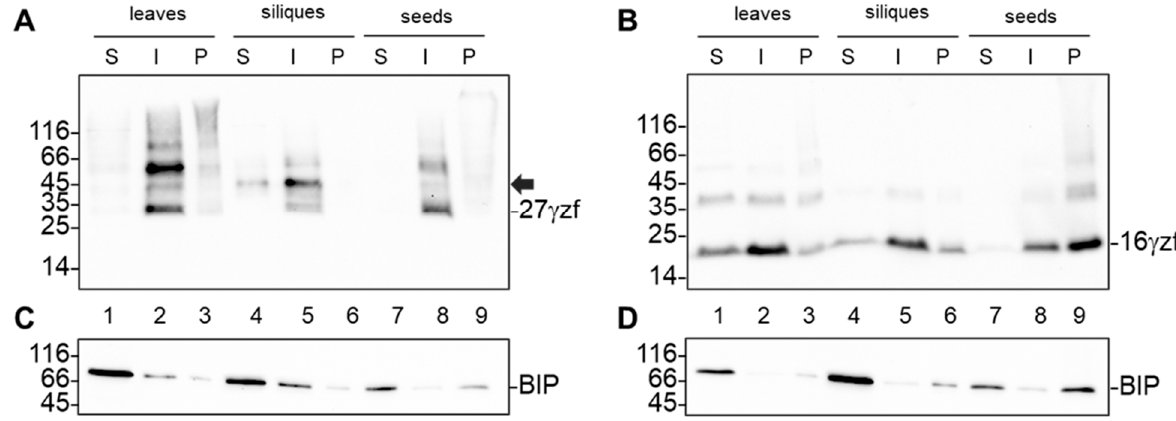
Figure 4. 16 γ zf forms insoluble aggregates in mature embryos, unlike 27 γ zf. Leaves, immature embryos (siliques) or dry seeds from 27 γ zf ( A , C ) or 16 γ zf ( B , D ) transgenic Arabidopsis plants were homogenized in saline buffer supplemented with nonionic detergent to solubilize membranes, in the absence of reducing agents. Soluble (S) proteins were collected after centrifugation. Pellets were resuspended in the same buffer supplemented with 4% 2-Mercaptoethanol to reduce disulfide bonds; the new soluble proteins (I) were separated from the completely insoluble pellet (P) by centrifugation. Analysis was done by SDS-PAGE and protein blot. ( A , B ): anti-FLAG antibodies; the positions of 27 γ zf and 16 γ zf monomers are indicated. The black arrow in A indicates the 27 γ zf modified form only present in vegetative tissues. ( C , D ): anti-BIP antibodies; the position of BiP is indicated.